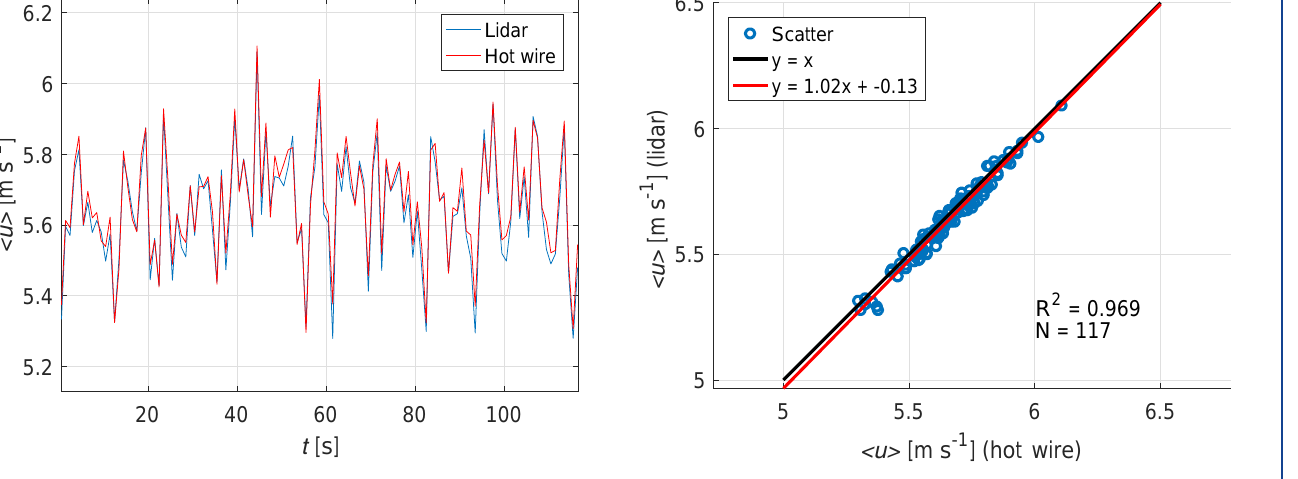
Figure 14. Visual comparison of the 1Hz averaged u component.